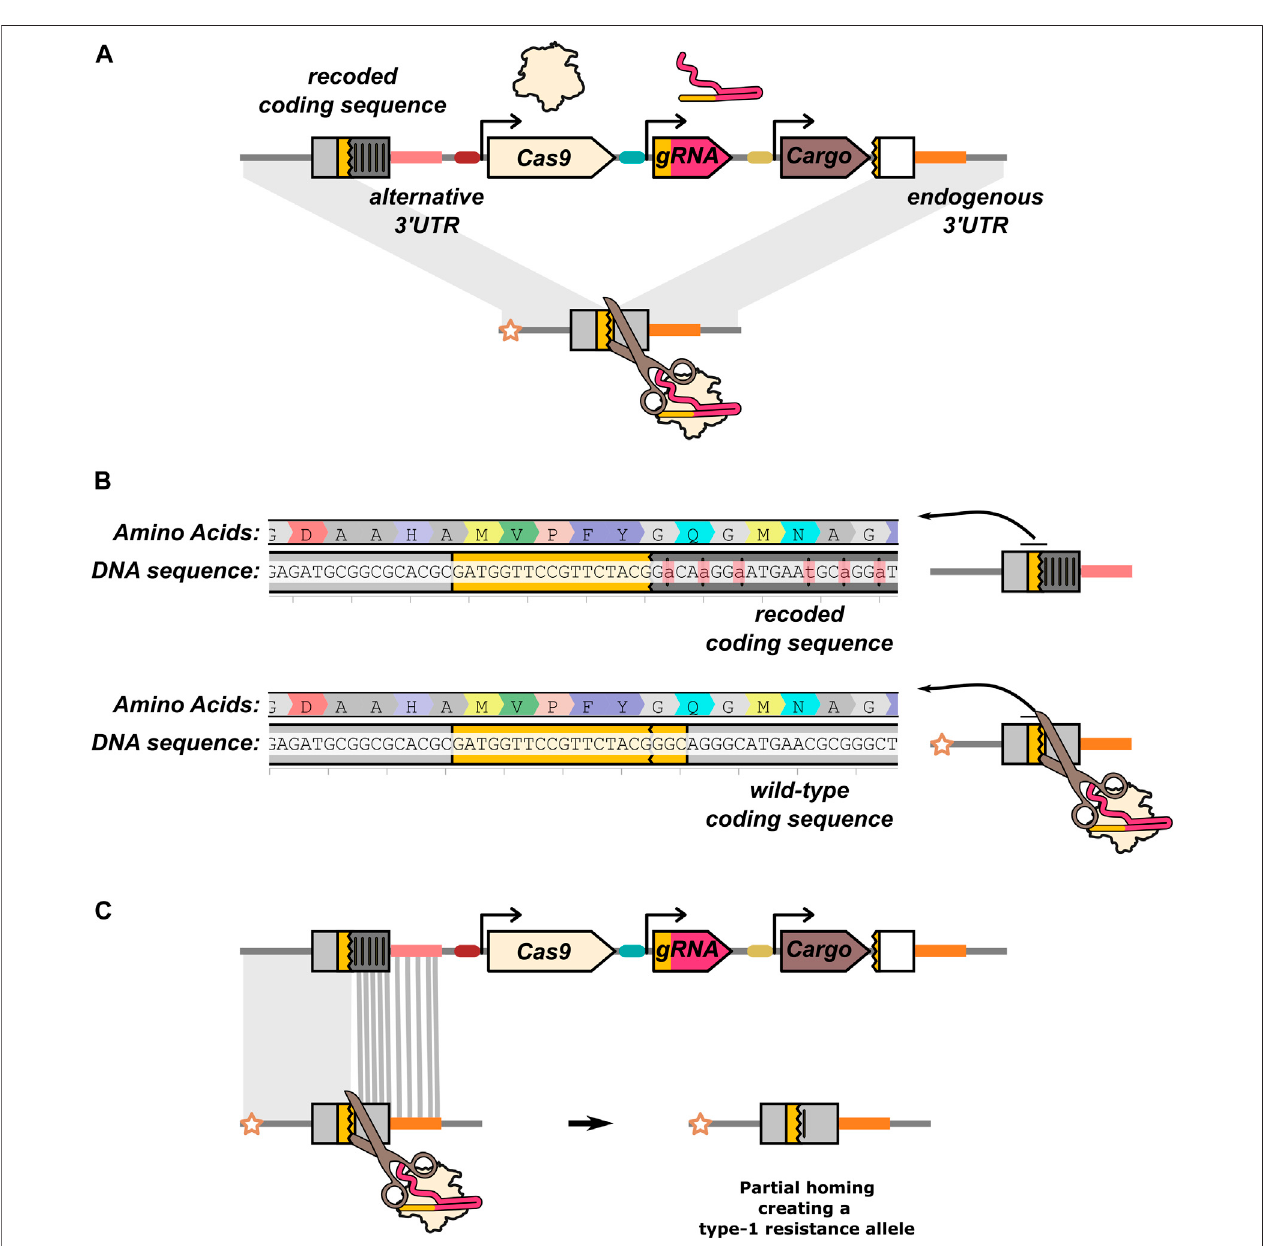
FIGURE 6 | Rescue HEG targeting an essential gene. (A) In addition to the nuclease components (Cas9 and gRNA), the drive element carries an effector/cargo gene and a “ rescue ” sequence that restores the function of the gene the HEG is disrupting. The rescue sequence allows the drive element to be more fi t than type-2 resistance alleles. The effector function of the rescue HEG is mediated by a separate cargo gene. In all other illustrations in this manuscript, the effector function of the drive is assumed to be mediated by disruption of the target gene and the HEG does not carry a rescue. (B) In this example, the rescue is a recoded version of an endogenous gene. Synonymous codon changes have been made to prevent partial homing (and recognition by the gRNA). (C) The recoded gRNA target sequence is located at the start of the rescue sequence. Partial homing by means of any part of the recoded sequence would generate a type-1 resistance allele. The recoding and gRNA target sequence is taken from (Pham et al.,